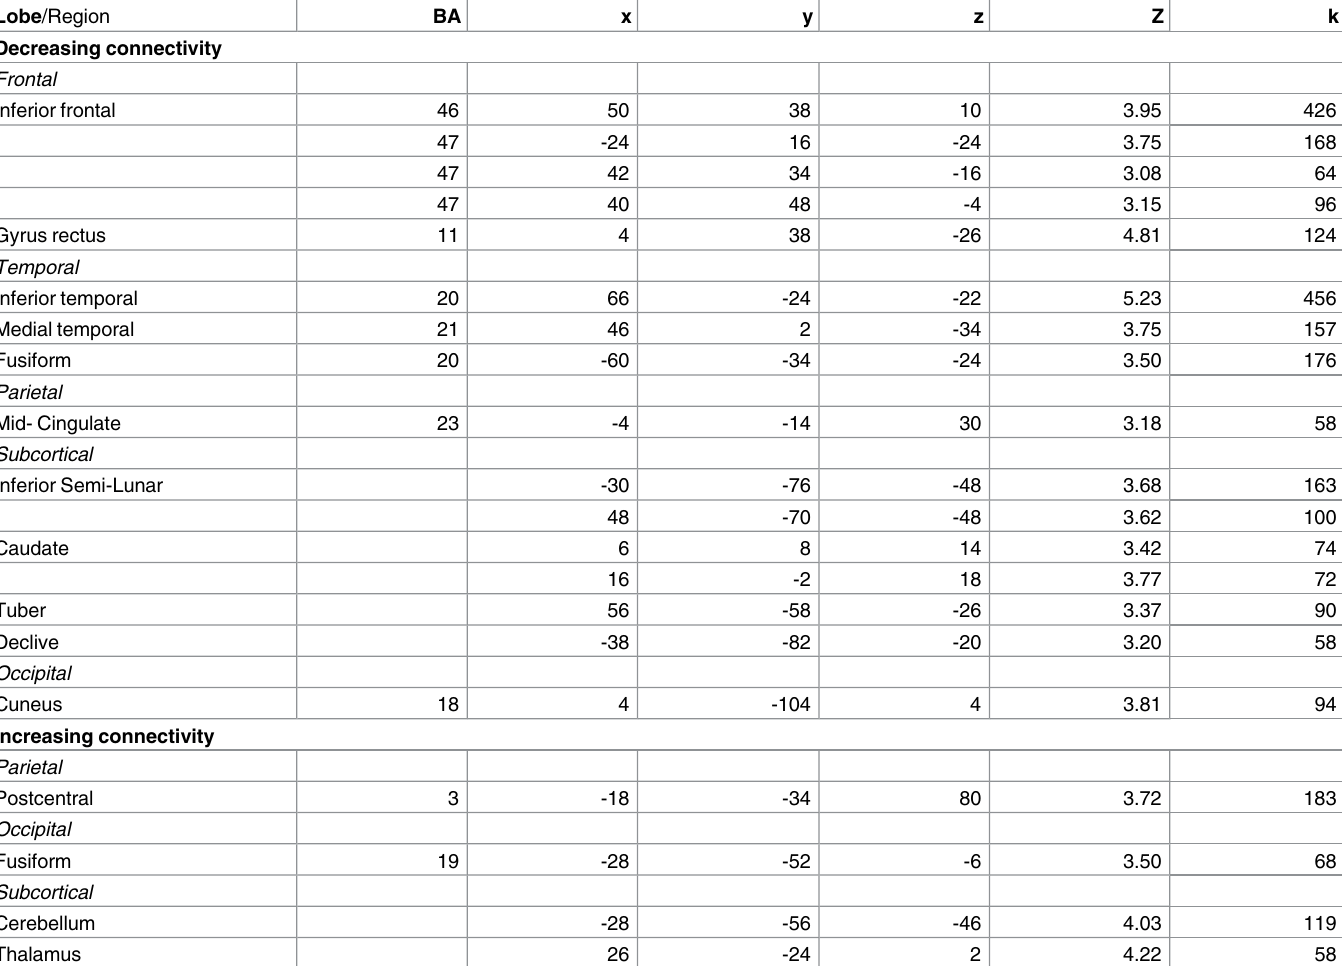
Table 3. Significant Changes in whole Brain Resting State Functional Connectivity with the Left Posterior Cingulate Seed among Youth Random- ized to Eight weeks of Rumination-Focused Cognitive Behavior